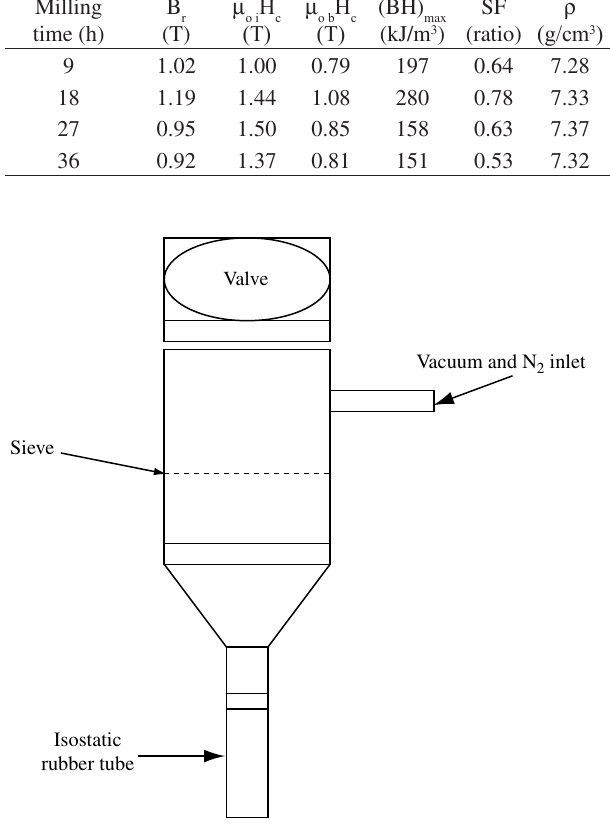
Figure 1. Schematic drawing of the powder transfer apparatus .